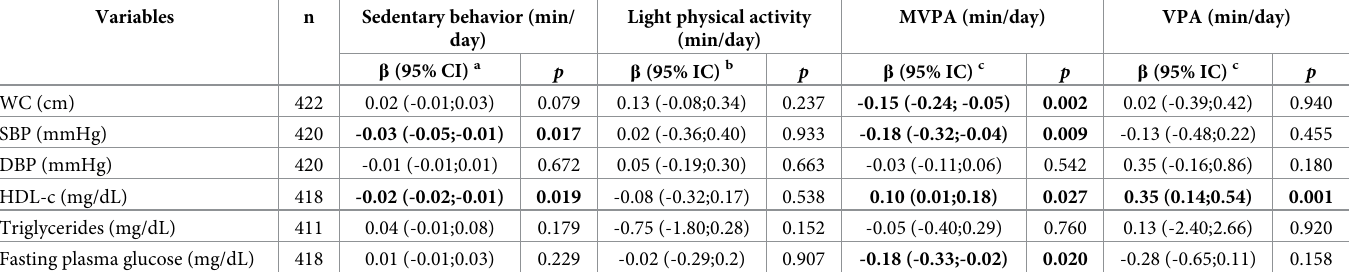
Table 2. Multiple linear associations of sedentary time and physical activity with cardiometabolic variables in Brazilian older adults. EpiFloripa Idoso Study. Floria- no´polis, 2015.